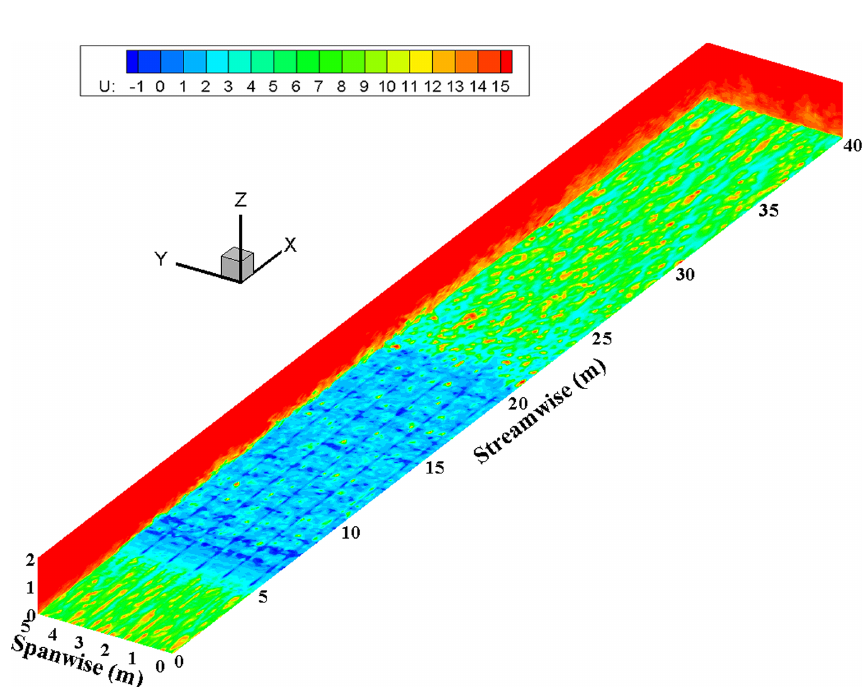
Figure 2. Schematic diagram of three-dimensional wind-blown sand in the presence of SCBs.